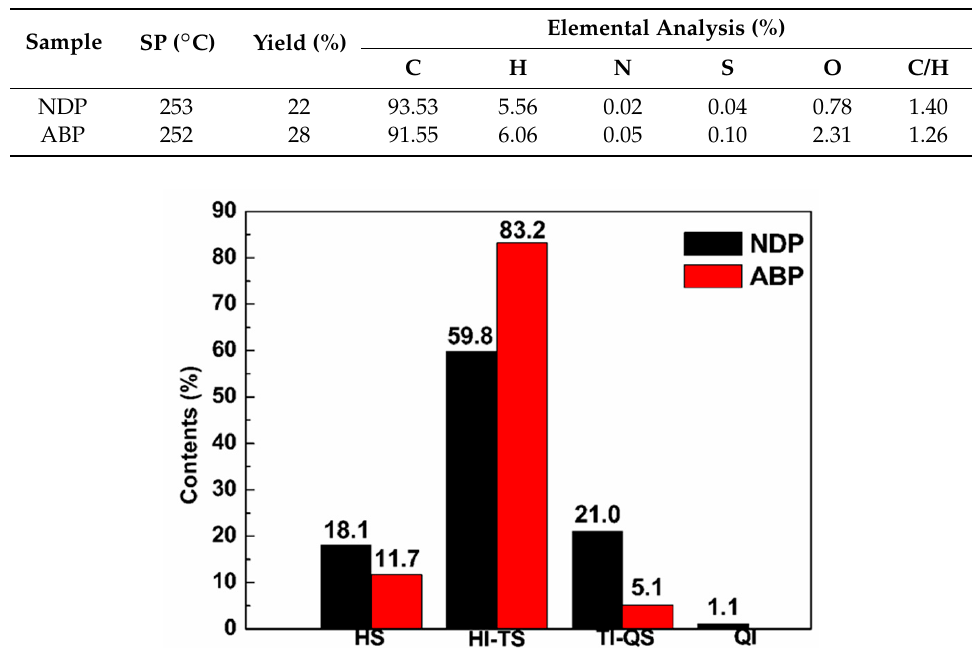
Table 1. Softening point (SP), pitch yield, and elemental analysis results of the air-blown pitch (ABP) and the nitrogen-distilled pitch (NDP).